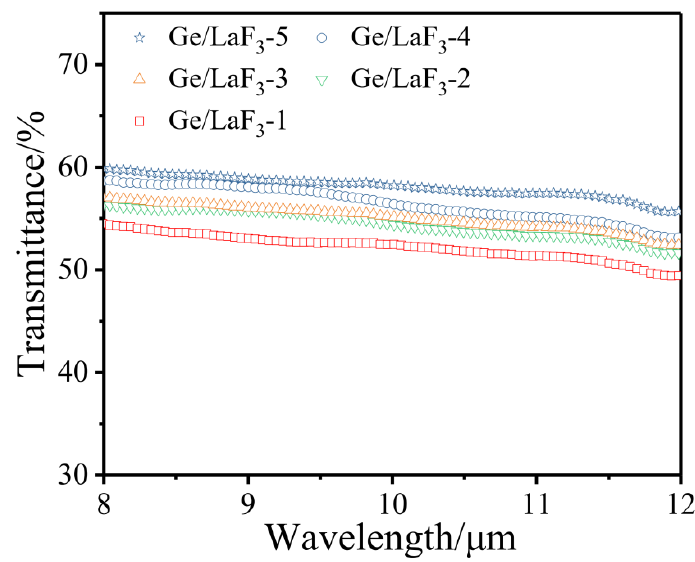
Figure 4. The transmission of LaF 3 films on Ge substrate with different oxygen contents.